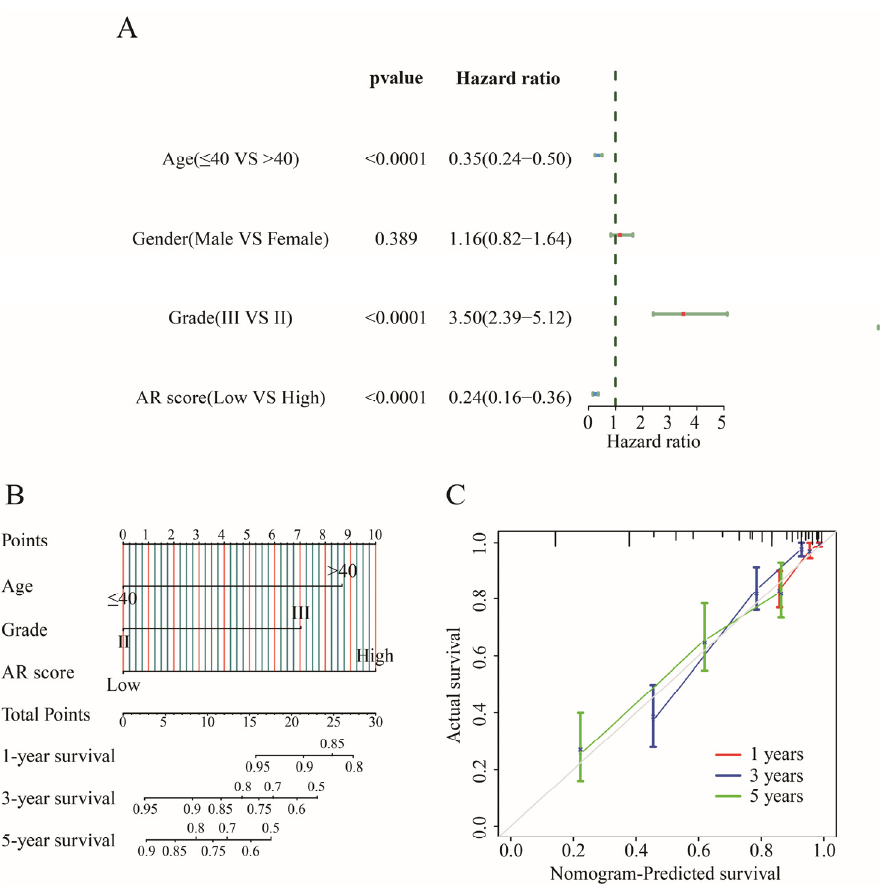
Figure 4. Construction of a nomogram. ( A ) The forest plot of univariate Cox regression analysis. ( B ) Nomogram for predicting the 1-, 3-, and 5-year OS of LGG patients. ( C ) Calibration curves of the nomogram for predicting of 1-, 3-, 5-year OS in patients with LGG.